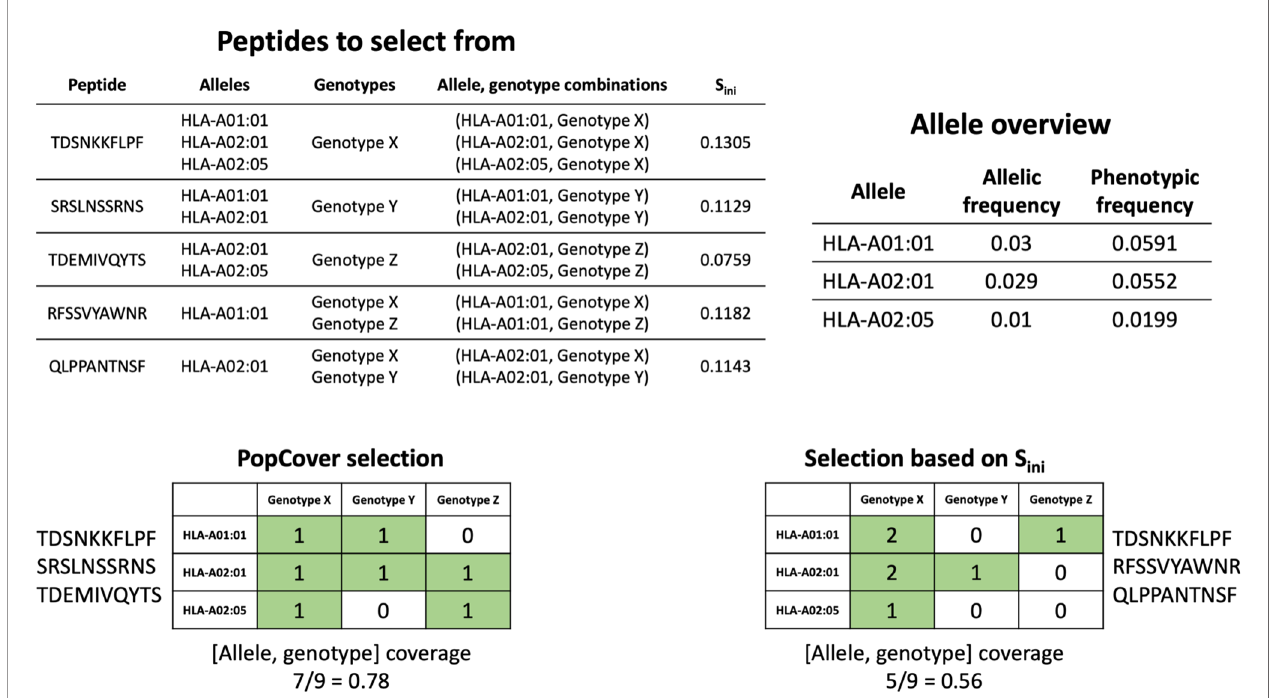
FIGURE 5 | Example of allele, genotype coverage calculation for a selection of three peptides using both the PopCover selection method and selection based only on S ini . The grid numbers in the selection matrices indicate how many times each combination of allele and genotype has been covered by the selected